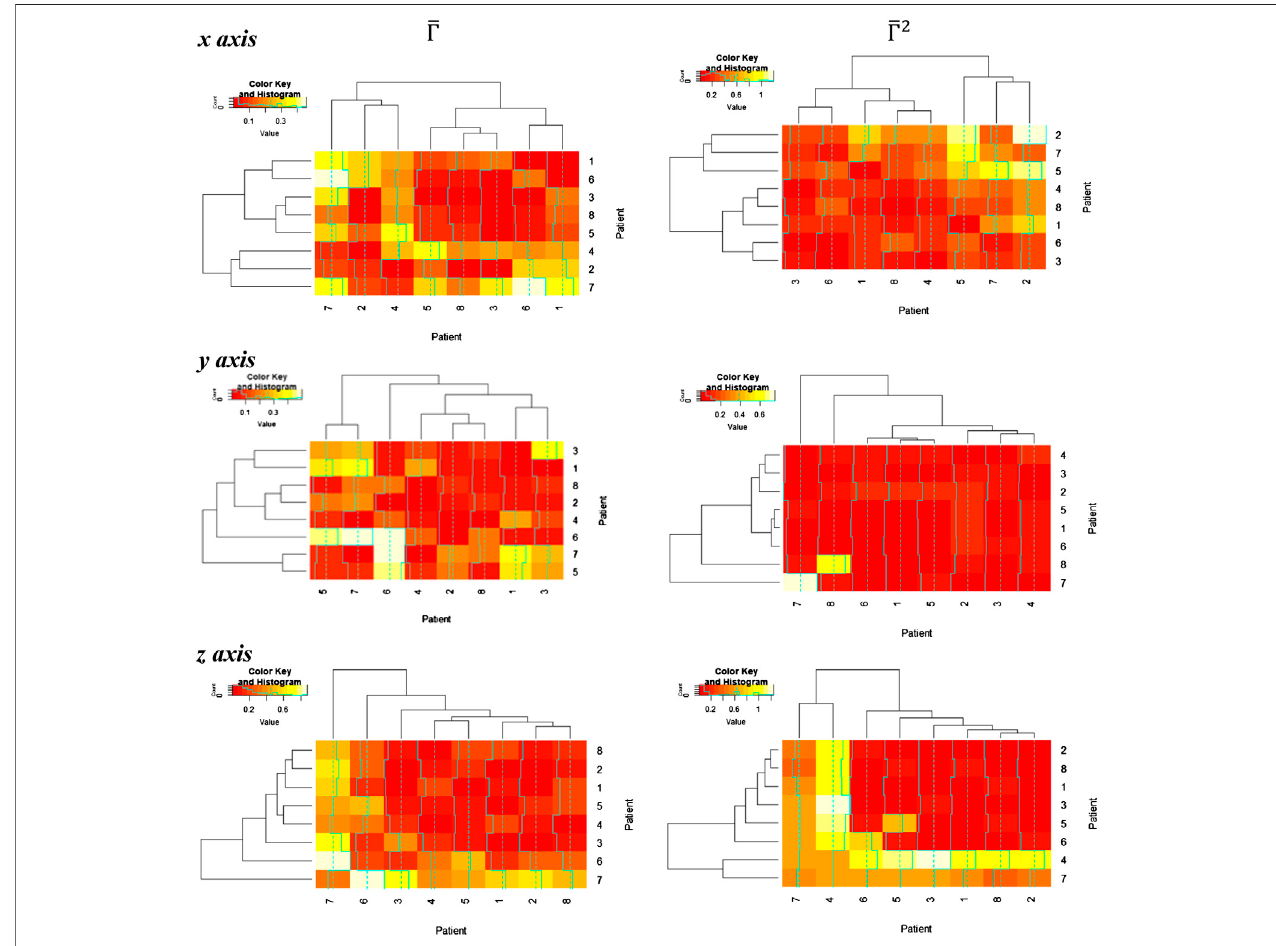
FIGURE6| Distortionmatrix M ( Γ kl ) and M ( Γ kl 2 ) for Γ k ECG ( t ) ,thenormalizedtimeseriesoftheECG,and Γ k accel , i ( t ) ,thenormalizedtimeseriesoftheaccelerationon the axis i ( i (cid:2) { x , y , z }) .